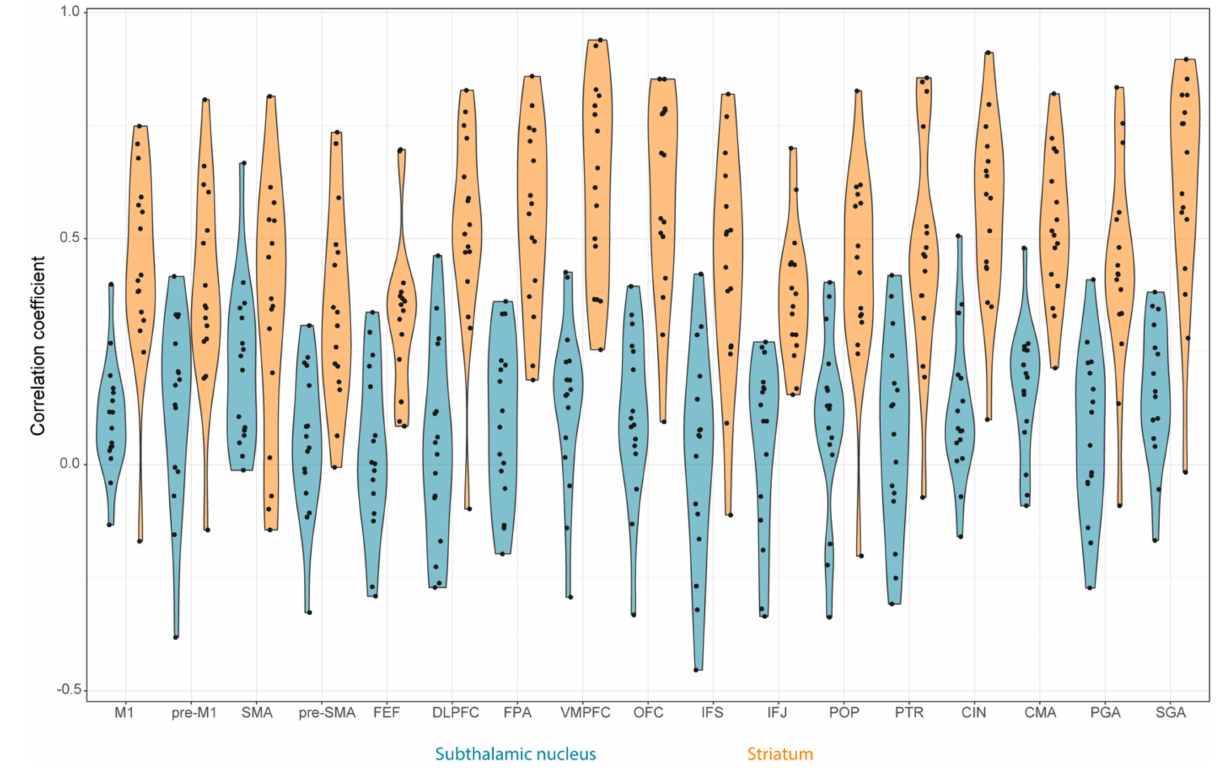
Frontiers in Neuroanatomy |